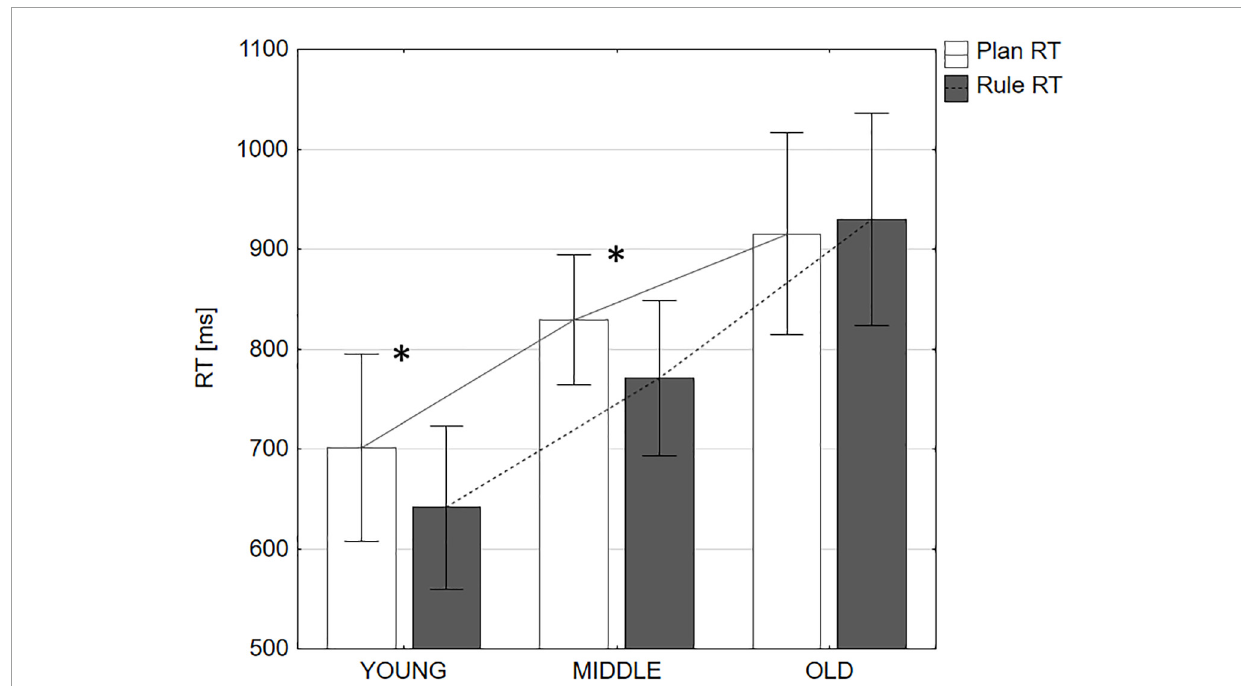
FIGURE2 Plan- and rule-task mean reaction times (RT) per age group are given in milliseconds (ms). Error bars represent 95% confidence intervals. Significant median differences within age groups are marked with ∗ .